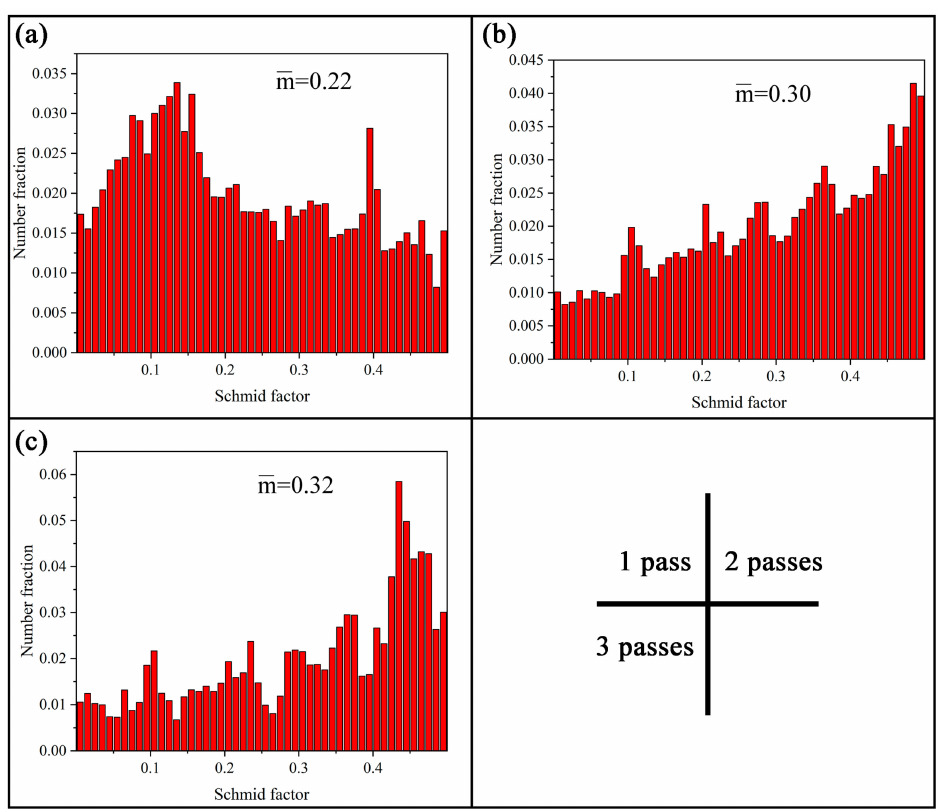
Figure 15. Distribution of the Schmid factor of basal slip of samples after di ff erent numbers of CEE-AEC passes: ( a ) 1 pass, ( b ) 2 passes, and ( c ) 3